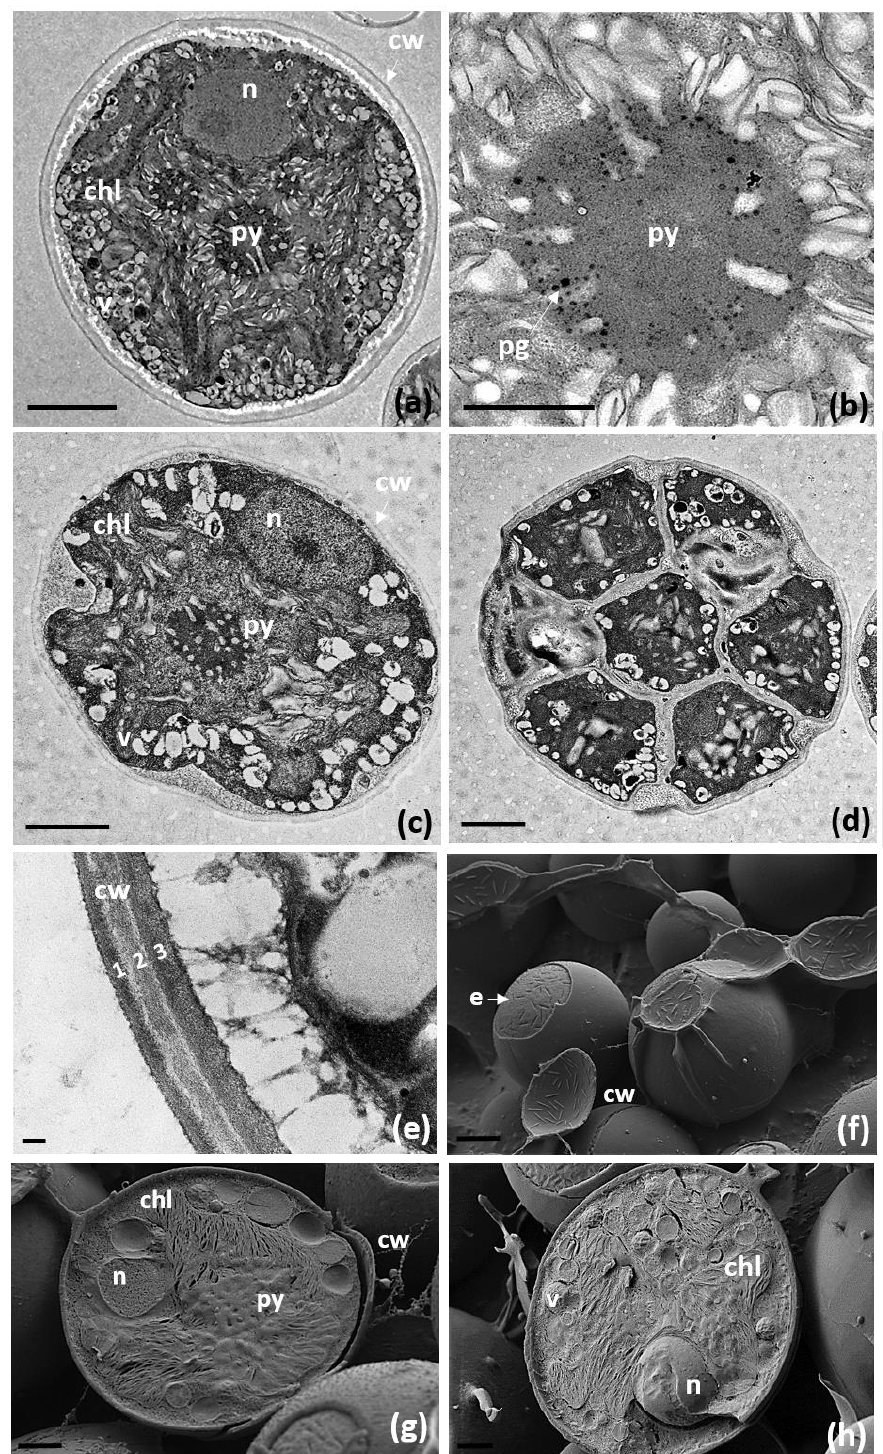
Figure 2. The TEM micrographs of the ultrastructure of Trebouxia lynnae sp. nov. in culture: ( a , c ) T. lynnae cells; ( b ) detail of pyrenoid; ( d ) aplanospore ( e ) detail of the cell wall containing three layers (1,2,3); ( f – h ) cryo-SEM images of the entire ( f ) and broken cells ( g , h ), arrow points at the eisosome attached to the outer layer of the plasma membrane ( f ). Abbreviations: chl (chloroplast), cw (cell wall), e (eisosomes), n (nucleous), Py (pyrenoid), and v (vesicles). Scale bars: ( a ) = 2 μm, ( b ) = 1 μm, ( c , d ) = 2 μm, ( e ) = 100 nm, ( f ) = 2 μm, ( g , h ) = 1 μm. Reference strain: ASUV 44 .